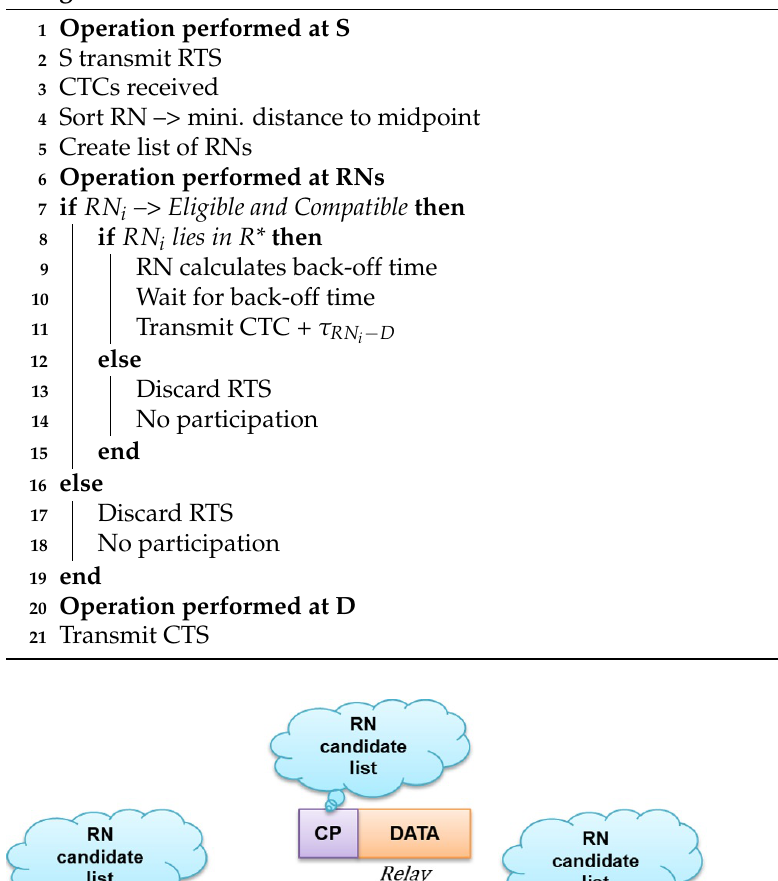
Algorithm 1 Initial Channel Reservation Phase